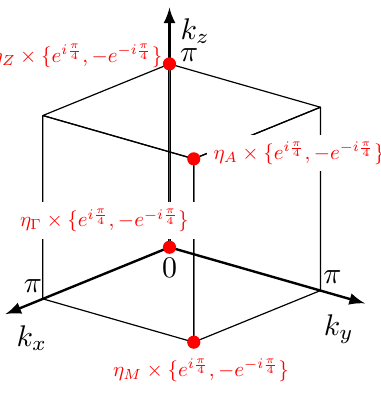
Figure 5: The eigenvalues of the ˜ R four-fold rotoinversion symmetric points on the